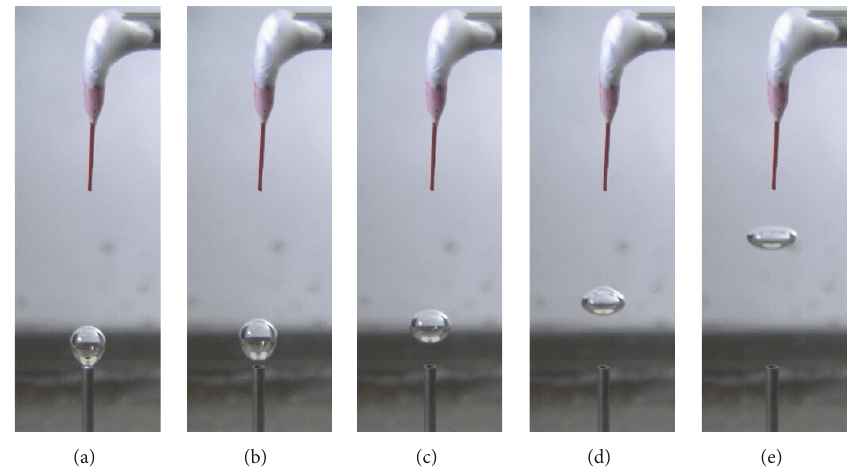
Figure 12: Images of the bubble shape before contacting the probe.